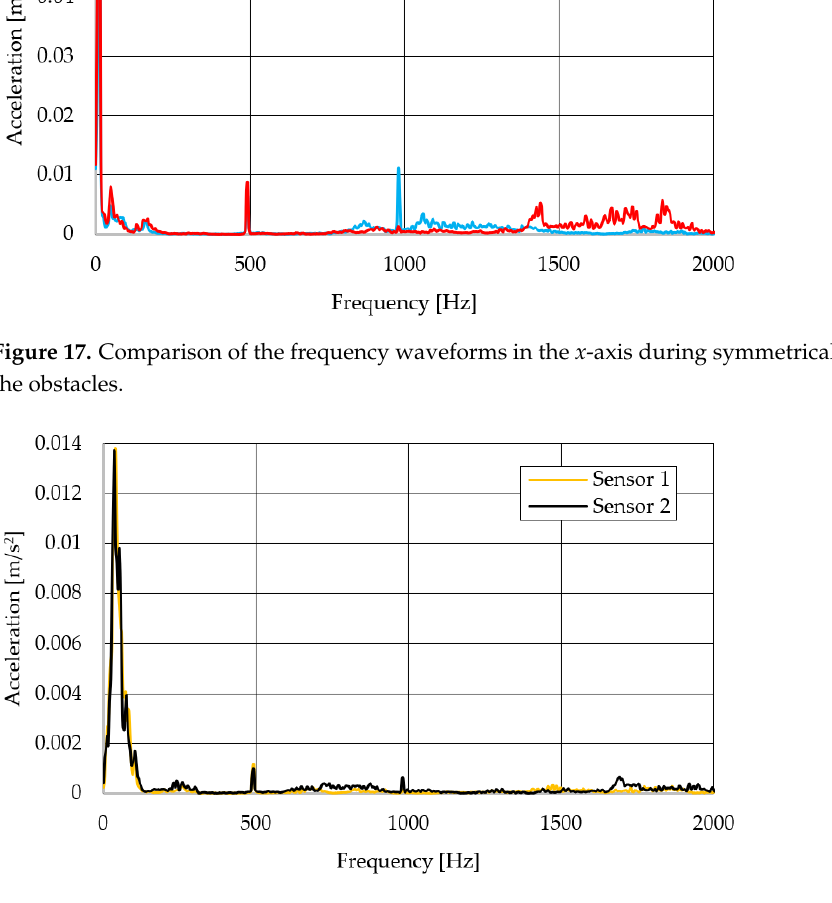
Figure 19. Comparison of the frequency waveforms in the z -axis during symmetrical crossing over the obstacles.